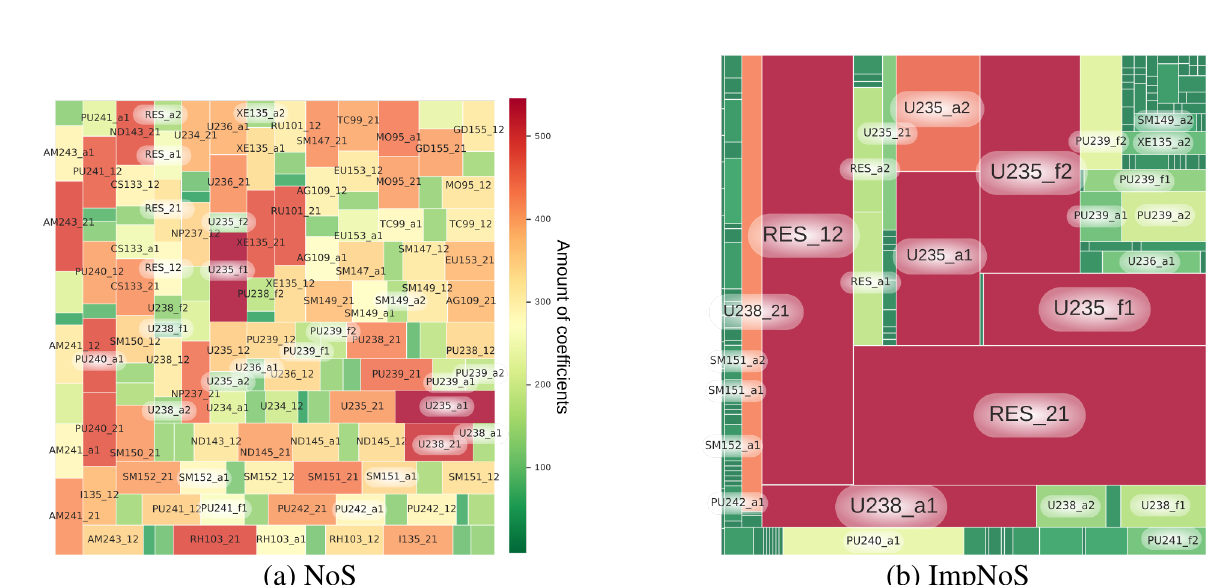
Figure 4: Library composition near ε . The area marks the relative amount of coefficients Σ ,(cid:63) for each cross section with respect to the total in the library. The colorbar is